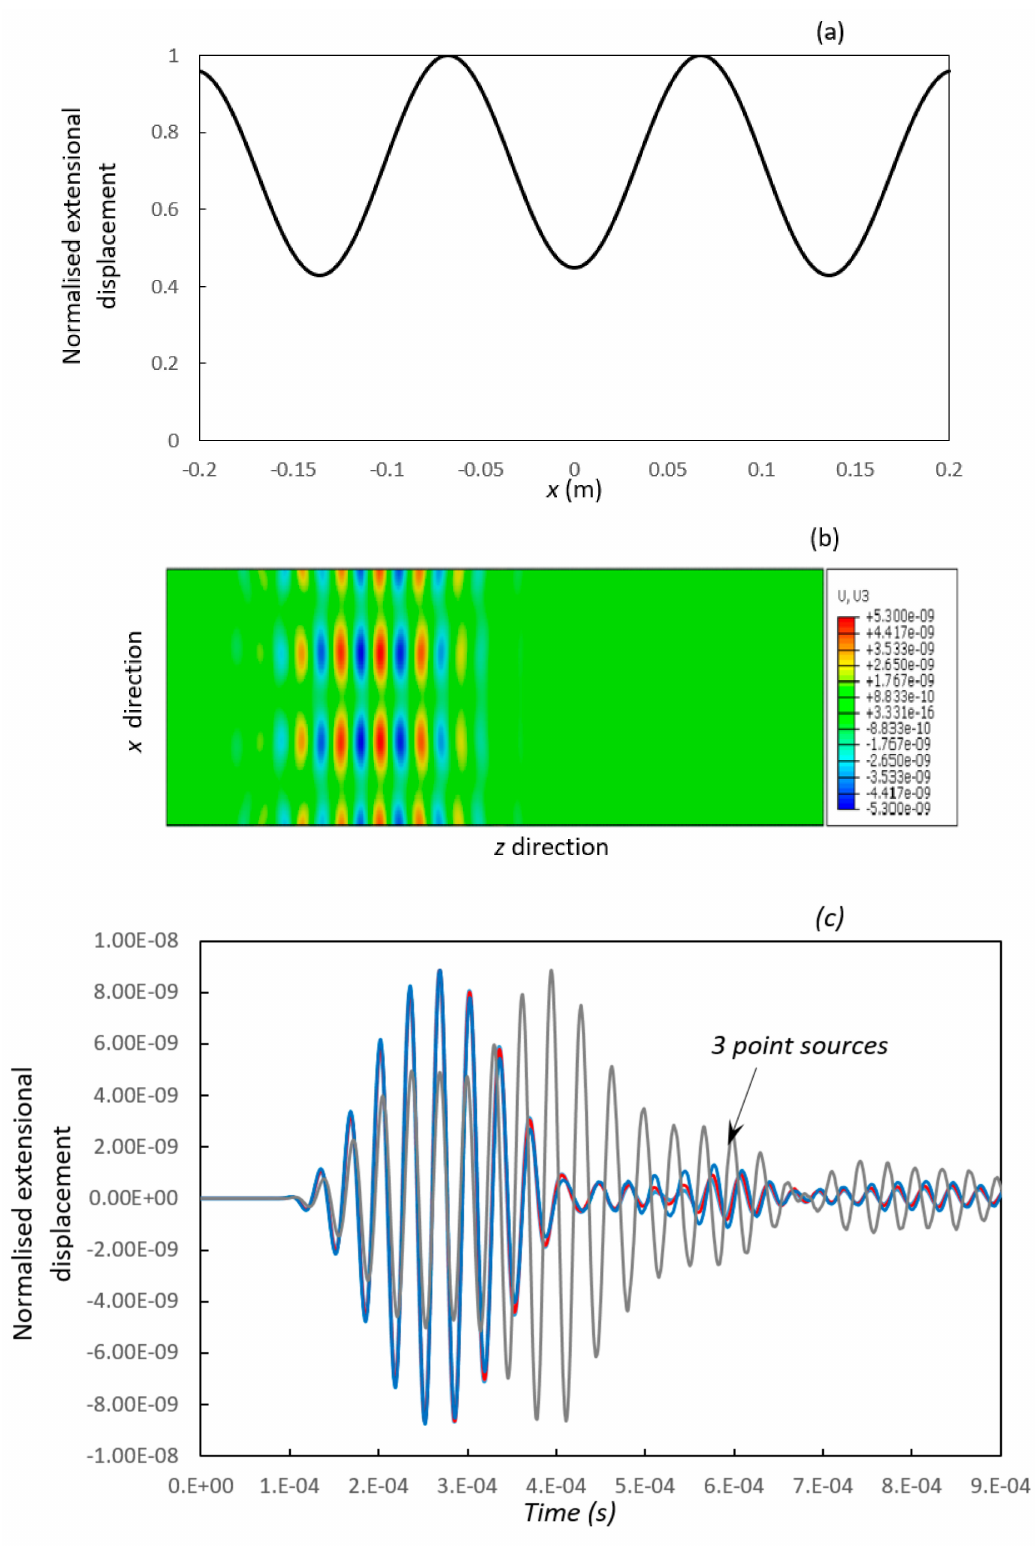
Figure 11. Excitation of extensional type mode E1*: ( a ) extensional displacement loading; ( b ) generated extensional displacement distribution (top view); ( c ) time domain displacement at receiver position. , 19 point sources; , 15 point sources; , 7 point sources; , 3 point